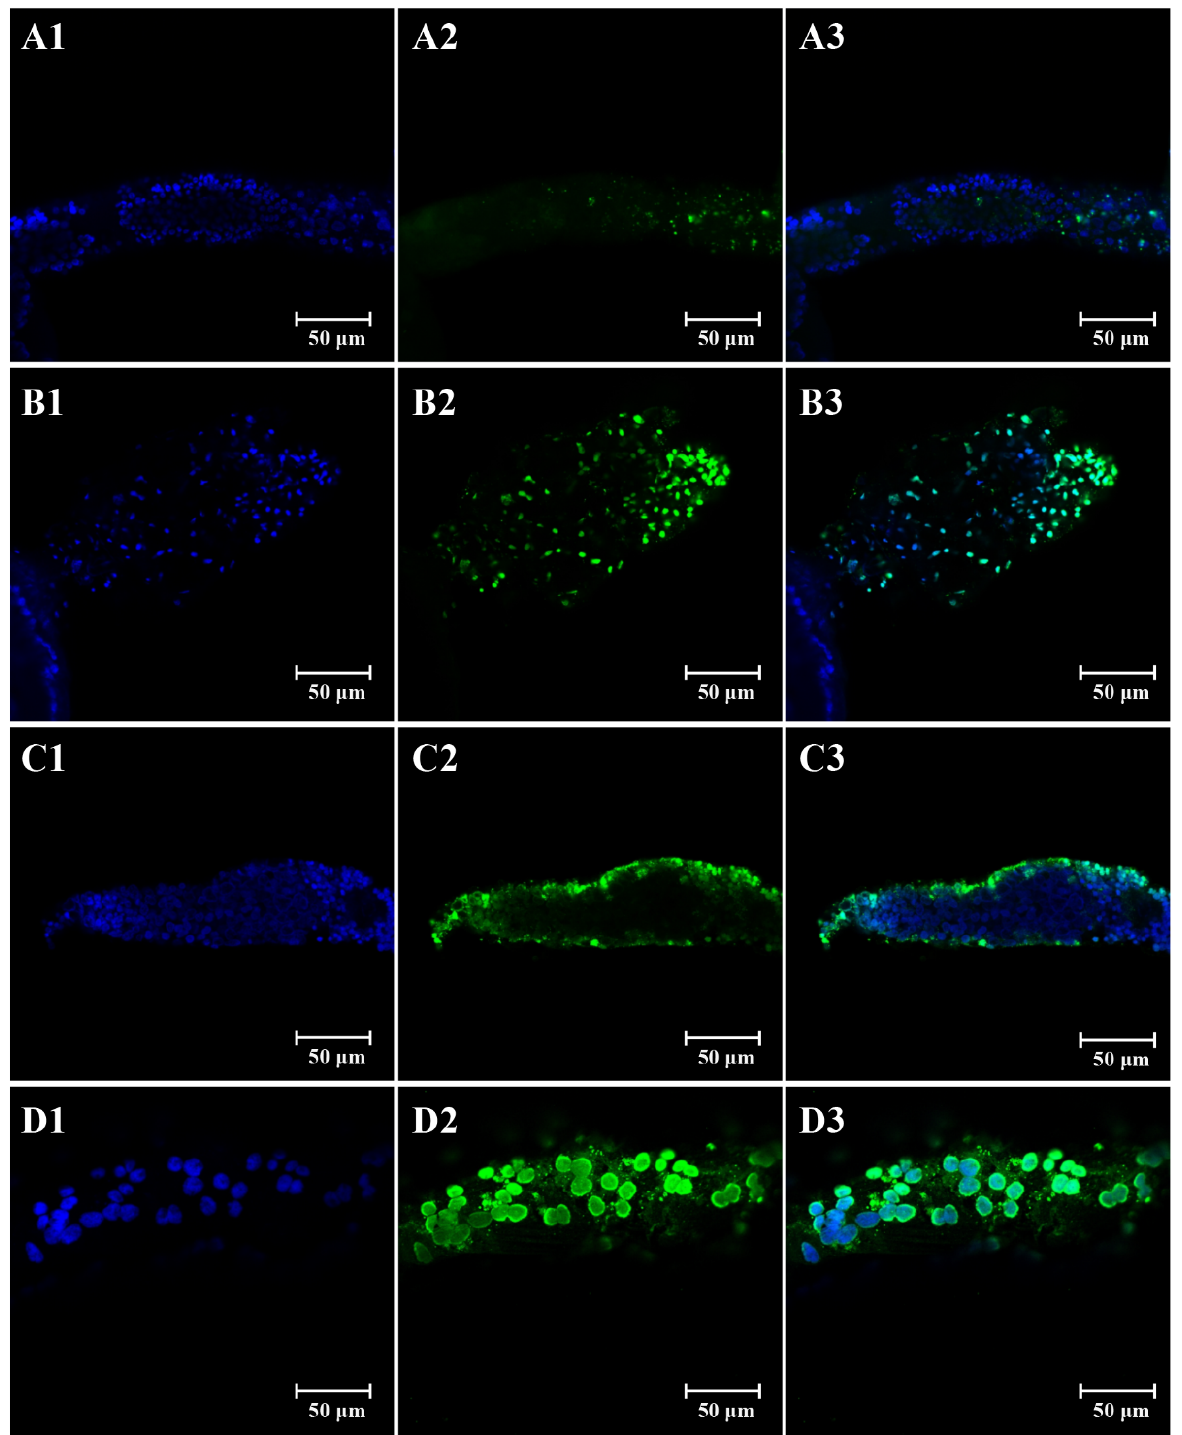
Figure 2. Images of DAPI- and TUNEL-stained SBPH tropharium cells after treatment with LC 10 of imidacloprid. Mor- phology of the organization and structure of the developing tropharia from 4-day-old control ( A ) and imidacloprid-treated ( B ) female SBPH, and the aged tropharia from 10-day-old control ( C ) and imidacloprid-treated ( D ) female SBPH. The DAPI- and TUNEL-positive cells were stained with blue ( A1 , B1 , C1 , D1 ) and green ( A2 , B2 , C2 , D2 ), respectively. ( A1 , B1 , C1 , D1 ) and ( A2 , B2 , C2 , D2 ) are merged as ( A3 , B3 , C3 , D3 ), respectively.